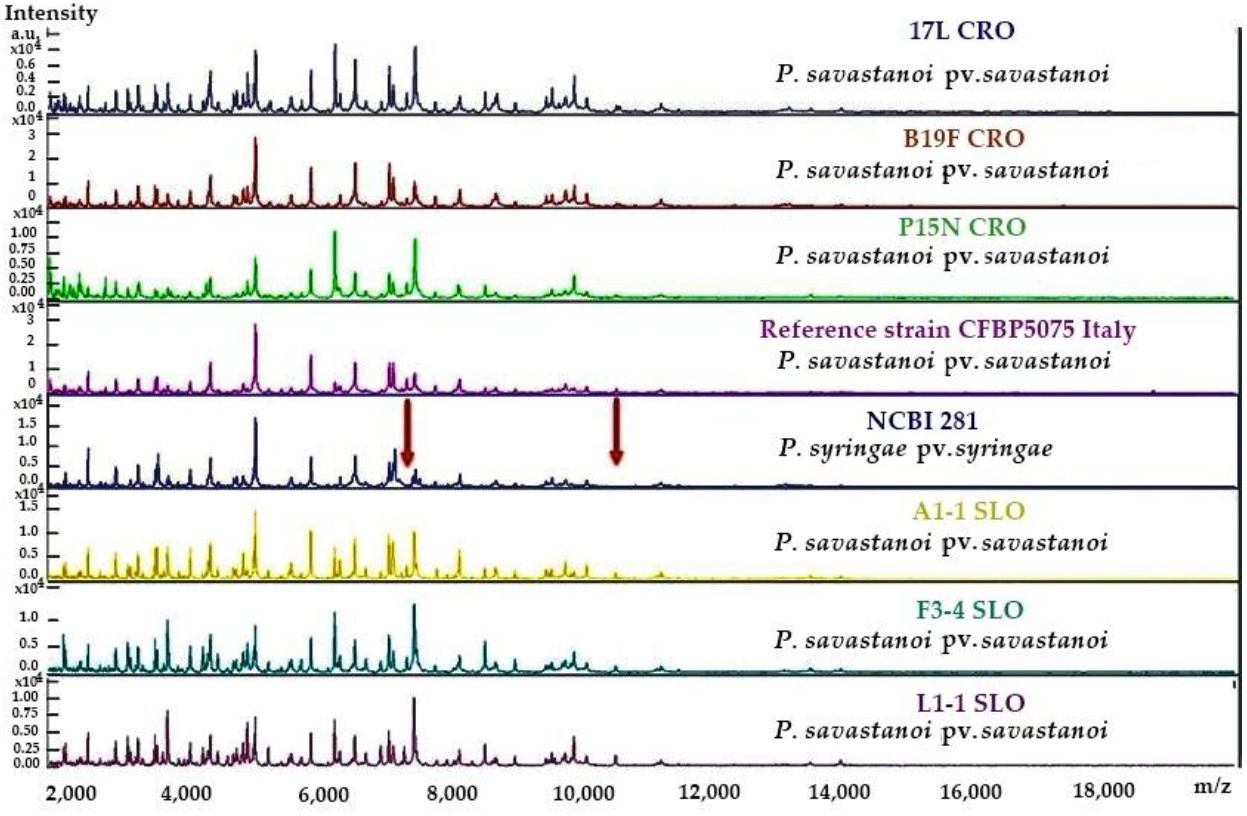
Figure 1. Example MALDI – TOF MS spectra of the six Pss strains described in this study and their comparison to Pss and P . syringae pv. syringae reference strains ’ spectra. The positions of two small protein peaks at approximately 7500–8000 m/z and 11,000 m/z that are lacking in P . syringae pv. Syringae are indicated by arrows. Axis x: mass per charge in Daltons ( m/z , Da); y axis: absolute intensity of the signal.